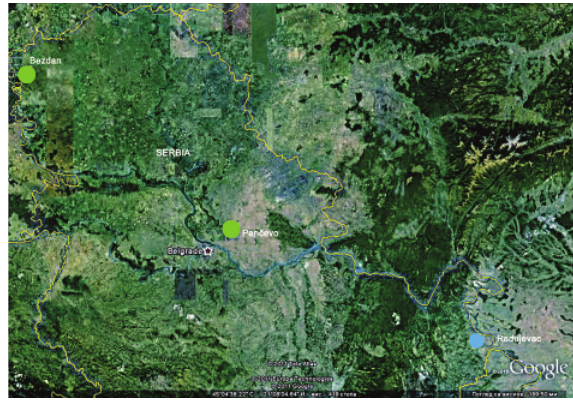
Figure 1: Map of the Danube water quality testing profiles.